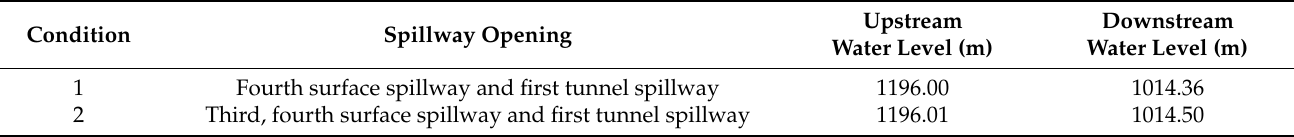
Figure 3. Arrangement of arch dam prototype flood discharge vibration measurement points. ( a ) The arch dam prototype; ( b ) Sensor arrangement for the arch dam vibration test; ( c ) DP-type dynamic displacement sensor; ( d ) DASP signal acquisition system. Table 1. Test conditions of discharge vibration of arch dam